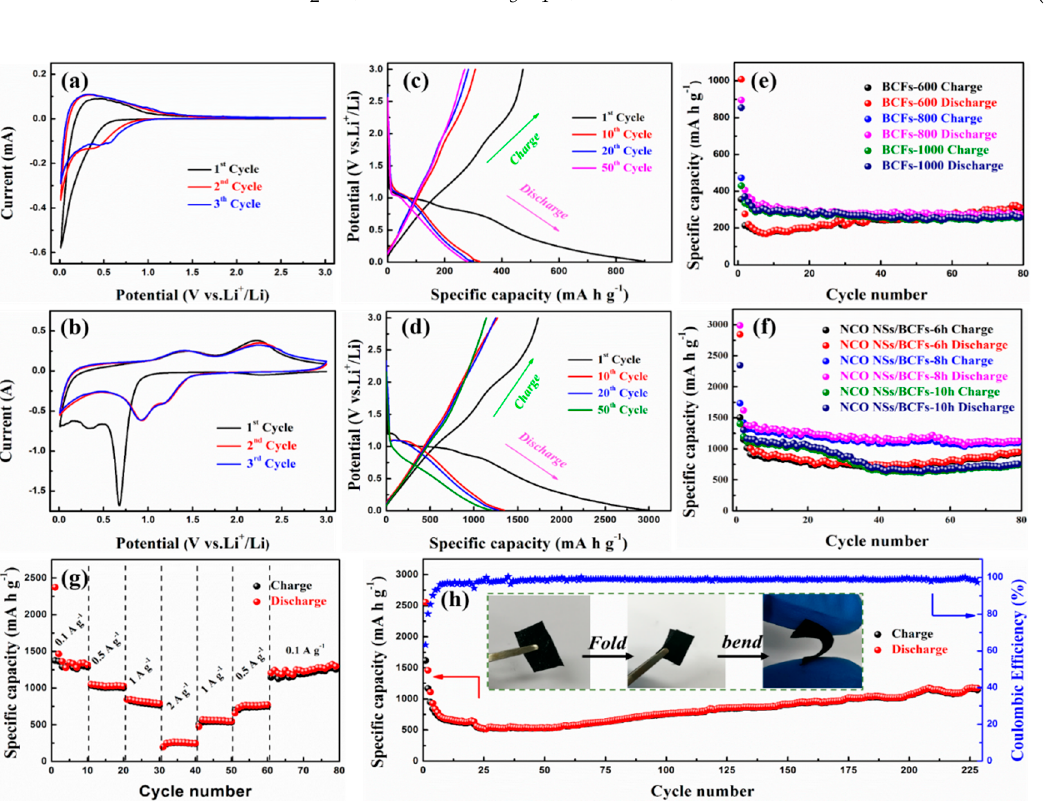
Figure 5. CV curves of ( a ) BCFs and ( b ) NCO NSs / BCFs; galvanostatic charge–discharge (GCD) profiles of ( c ) BCFs and ( d ) NCO NSs / BCFs; cycle performance of ( e ) BCFs and ( f ) NCO NSs / BCFs composite; ( g ) rate performance; ( h ) long cycle performance and corresponding coulombic e ffi ciency of NCO NSs / BCFs-8h.